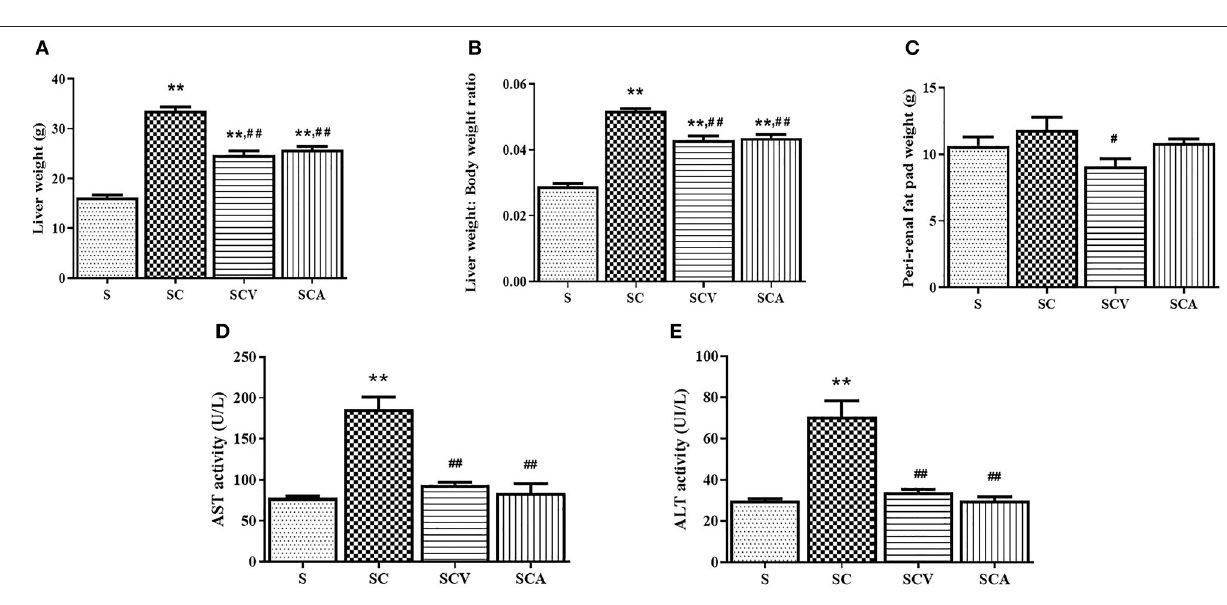
FIGURE 4 | Coconut vinegar supplementation reduced high cholesterol induced-hepatic injury and perirenal fat pad weight. (A) Liver weight; (B) Liver weight to body weight ratio; (C) Perirenal fat pad weight; (D) Aspartate amino-transferase (AST) activity; (E) Alanine aminotransferase (ALT) activity. Each bar presented in mean ± SEM. ** p < 0.01 vs. the control group; # p < 0.05; ## p < 0.01 vs. the SC group ( n = 6 per